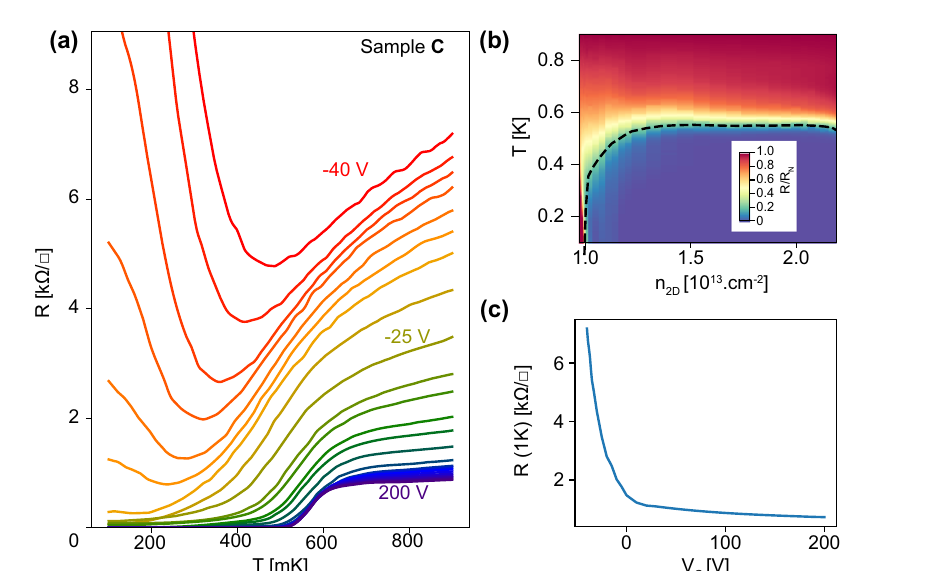
Fig. 3 | Electric fi eld effect and superconducting phase diagram. a Temperature dependenceofthesheetresistanceofsampleCfordifferentvaluesoftheback-gate voltage in therange − 40to 200V. b Normalized sheetresistanceincolorscaleasa functionofthecarrierdensityextractedfromHallmeasurementsandtemperature.